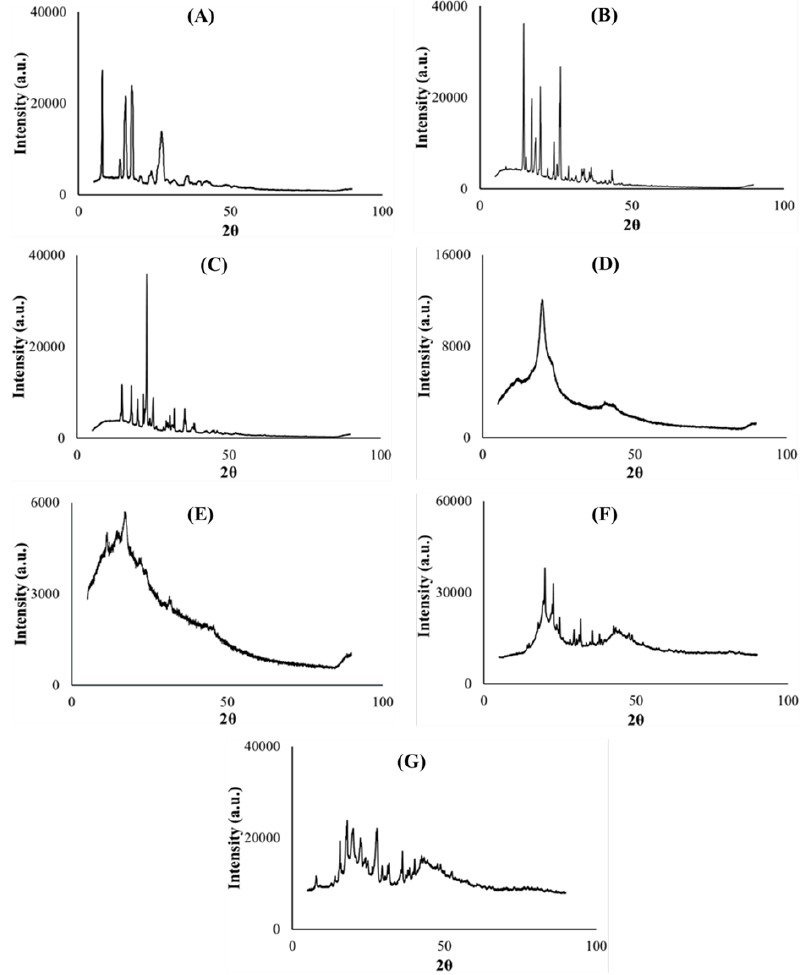
Figure 5. X-ray diffractograms of ( A ) PZA, ( B ) citric acid, ( C ) xylitol, ( D ) polyvinyl alcohol polyethylene glycol, ( E ) sodium starch glycolate, ( F ) placebo and ( G ) drug loaded formulation.